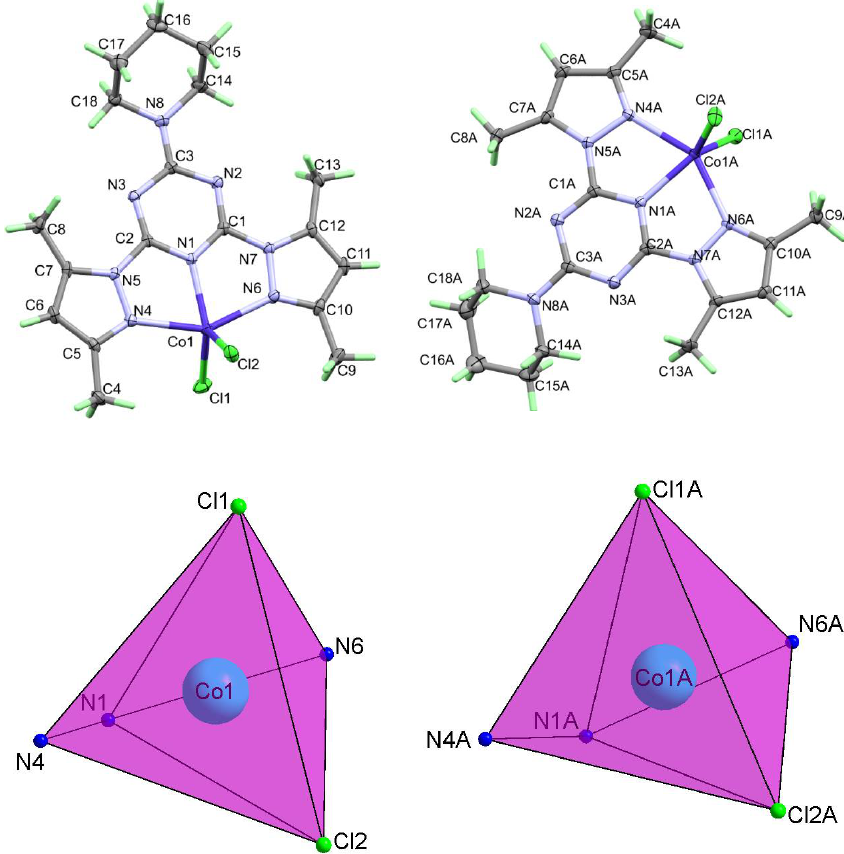
Figure 4. Structure with atom numbering (upper) and the distorted square pyramidal (lower) of 2 . The packing of complex molecules in 2 is controlled by Cl2 . . . H6A, Cl2 . . . H8A, and Cl2 . . . H13A contacts shown in Figure 5 (upper part). The donor (D)-acceptor (A) distances are 3.524(2), 3.768(2) and 3.611(2) Å, respectively (Table 3). The hydrogen-bonding network in which the complex units are interconnected via C-H . . . Cl interactions as shown in Figure 5 (lower part).